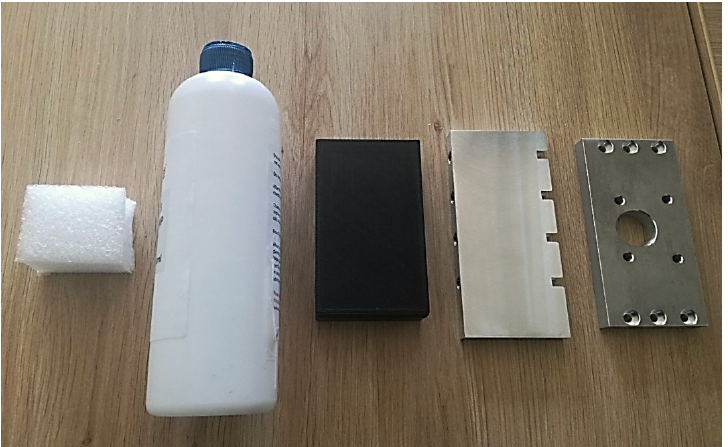
Figure 8. The five objects employed during the experiments. From left to right: styrofoam piece; soft cylinder; rigid plastic piece; metal piece; holed metal